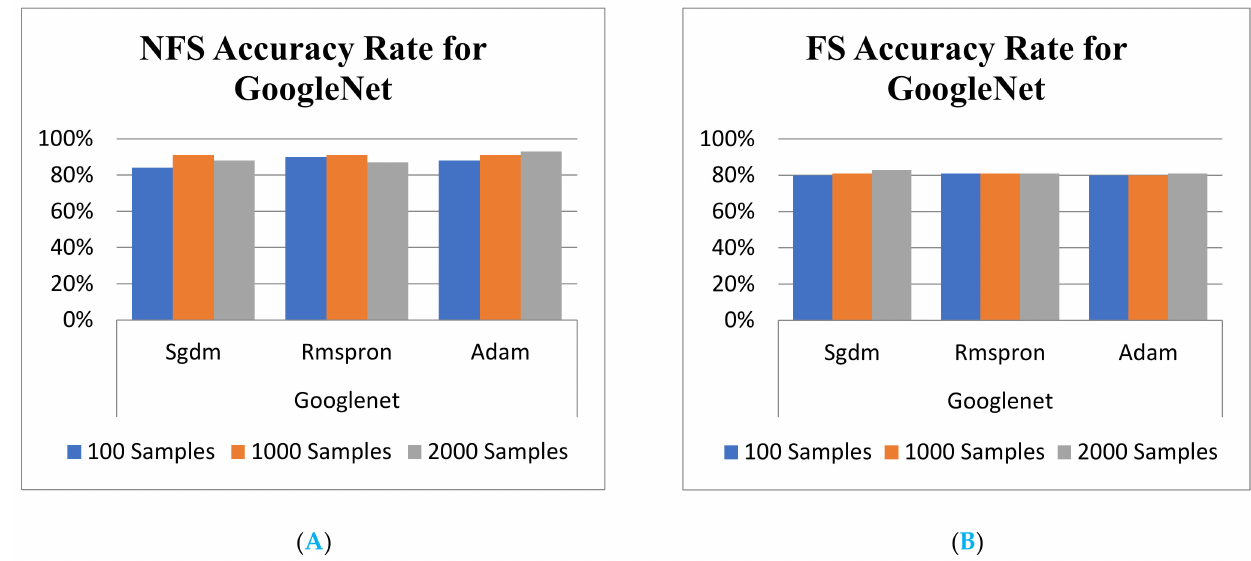
Figure 9. Validation Accuracy rate for GoogLeNet. ( A ) with FS; ( B ) without